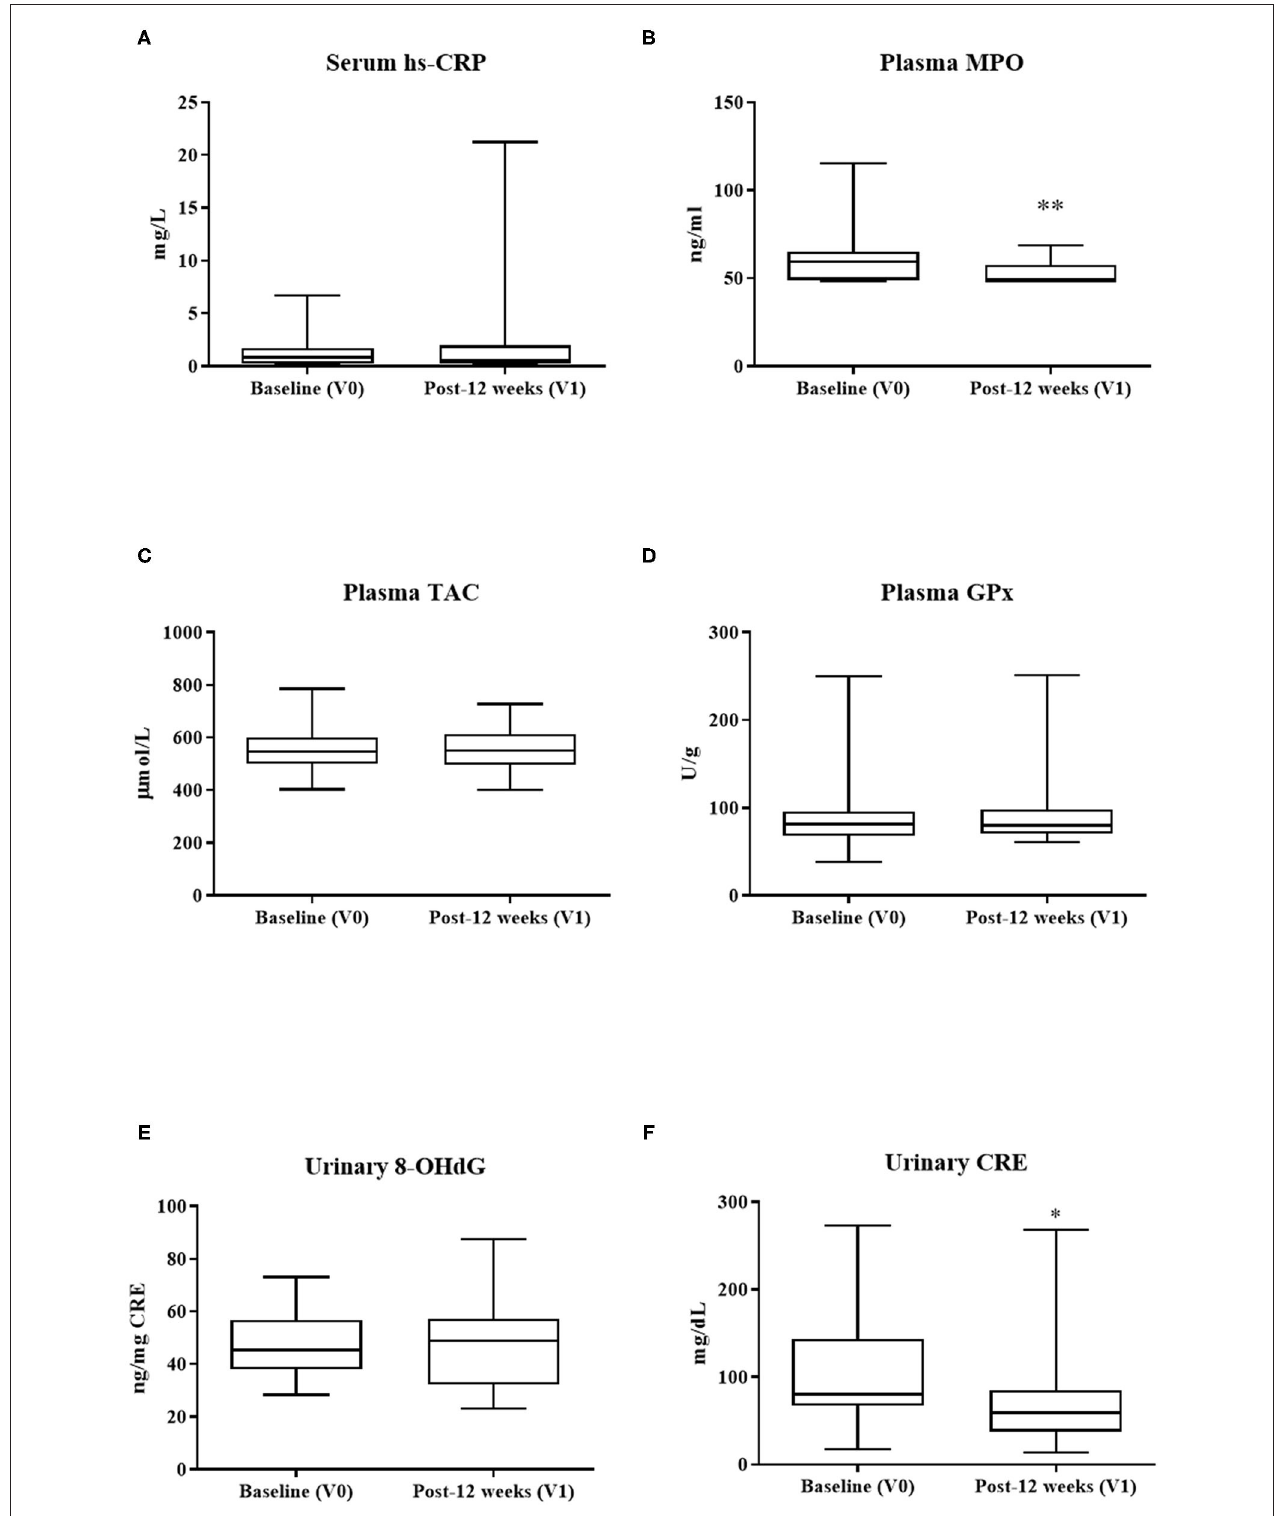
FIGURE 2 | The effect of PS128 intervention on metabolic parameters of (A) hs-CRP, (B) MPO, (C) TAC, (D) GPx, (E) 8-OHdG, and (F) CRE. * p < 0.05; ** p < 0.01 as compared to baseline (V0). Mean ± SD; P , Obtained from paired t test; hs-CRP, high-sensitivity C-reactive protein; MPO, myeloperoxidase; TAC, total antioxidant capacity; GPx, glutathione peroxidase; 8-OHdG, 8-hydroxy-2’-deoxyguanosine; CRE, creatinine.